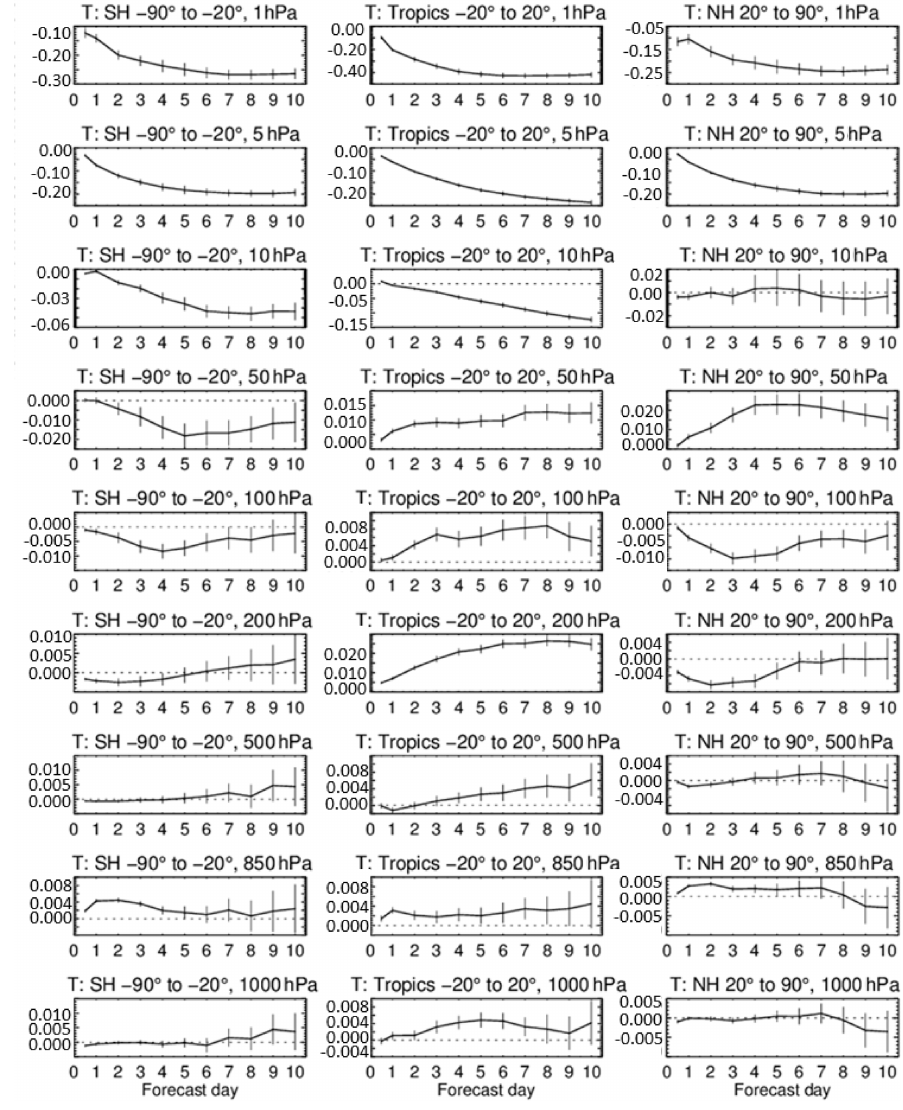
Figure 11. Normalised differences in root mean square error (DRMSE), as a function of lead time, in the forecast temperature field (K) between the experiment using the new interactive ozone scheme and the experiment using the default ozone climatology within the radiation code. The forecast model runs cover a 1-year period, with 10d forecasts from August 2012 to July 2013. The figure shows three latitudinal bands, 90–20 ◦ S (left column), 20 ◦ S–20 ◦ N (centre column) and 20–90 ◦ N (right column), for different pressure levels as labelled for each row, from 1.0 to